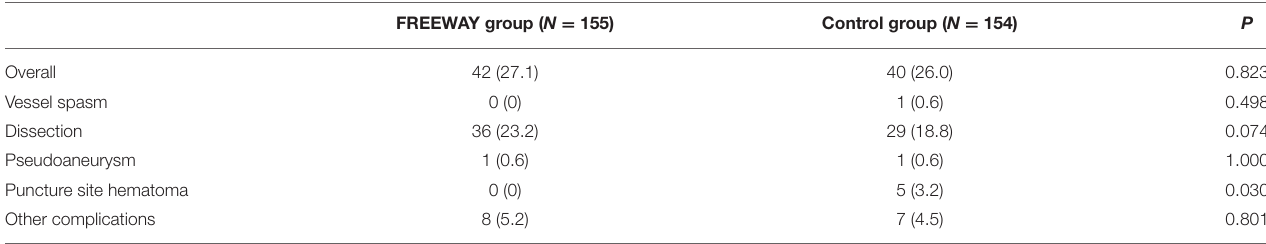
TABLE 3 | Complications in the procedures.